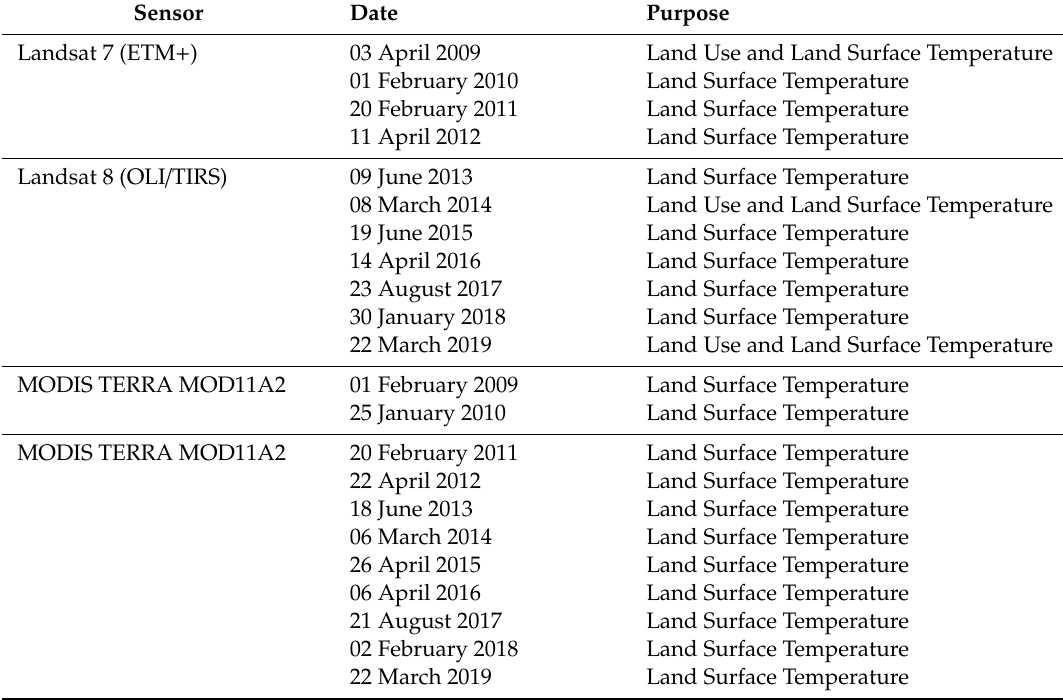
Table 1. Description of satellite sensors and acquisition date.